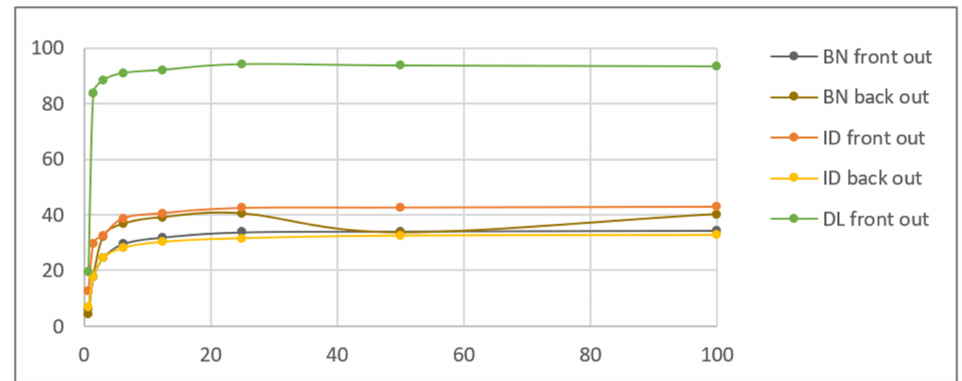
Figure 6. Results of the simulation performed using identity card (ID) and driving licence (DL) images—average brightness of the differential and output image vs. UV light image share %.